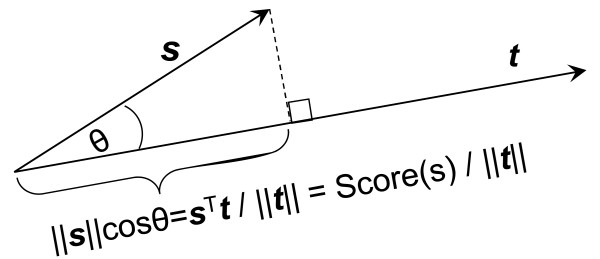
The orthogonal projection of s onto t. It can be seen that the projection of s onto t is equal to
Score(s)/||t||∝Score(s).